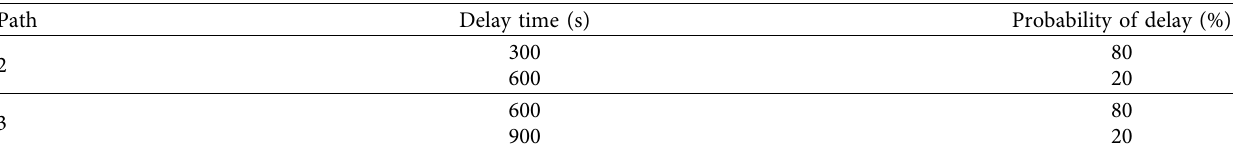
Table 6: Probability distribution of delay time.